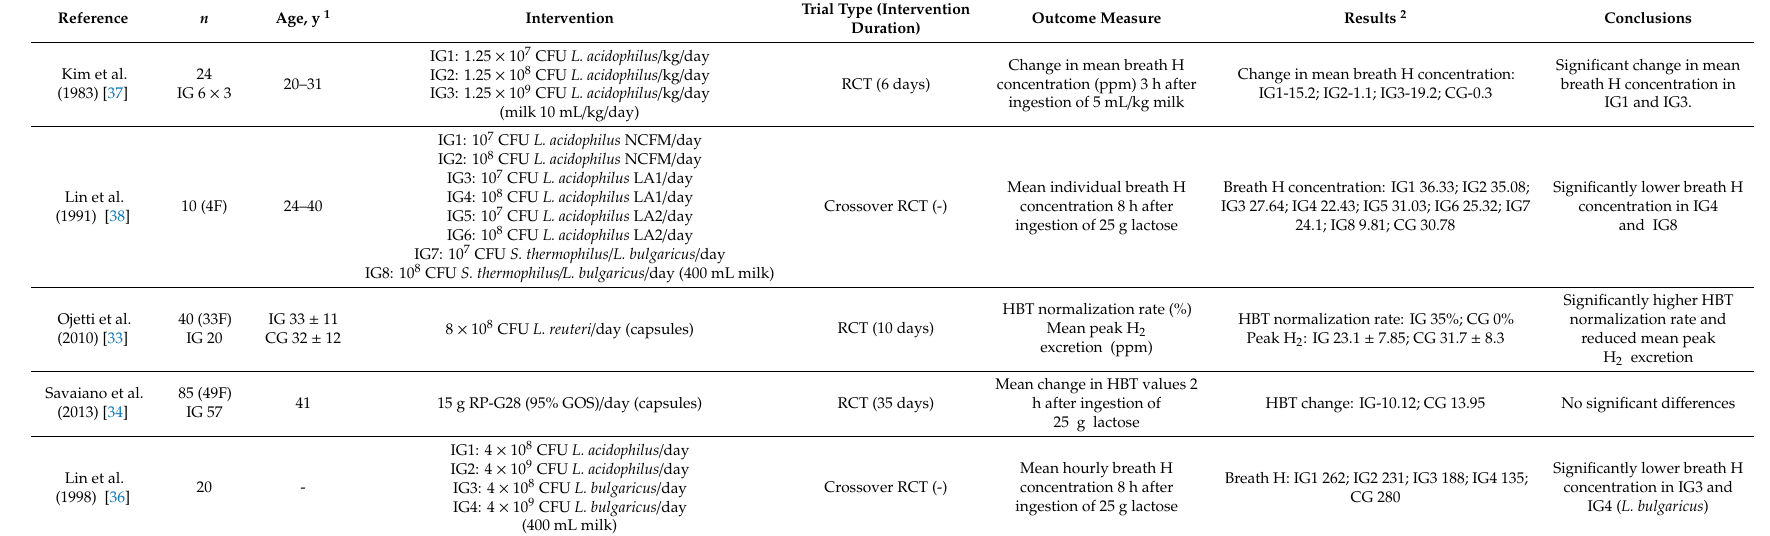
Table 3. E ff ects of prebiotics and probiotics on lactose digestion in 179 individuals with lactose malabsorption in controlled trials.